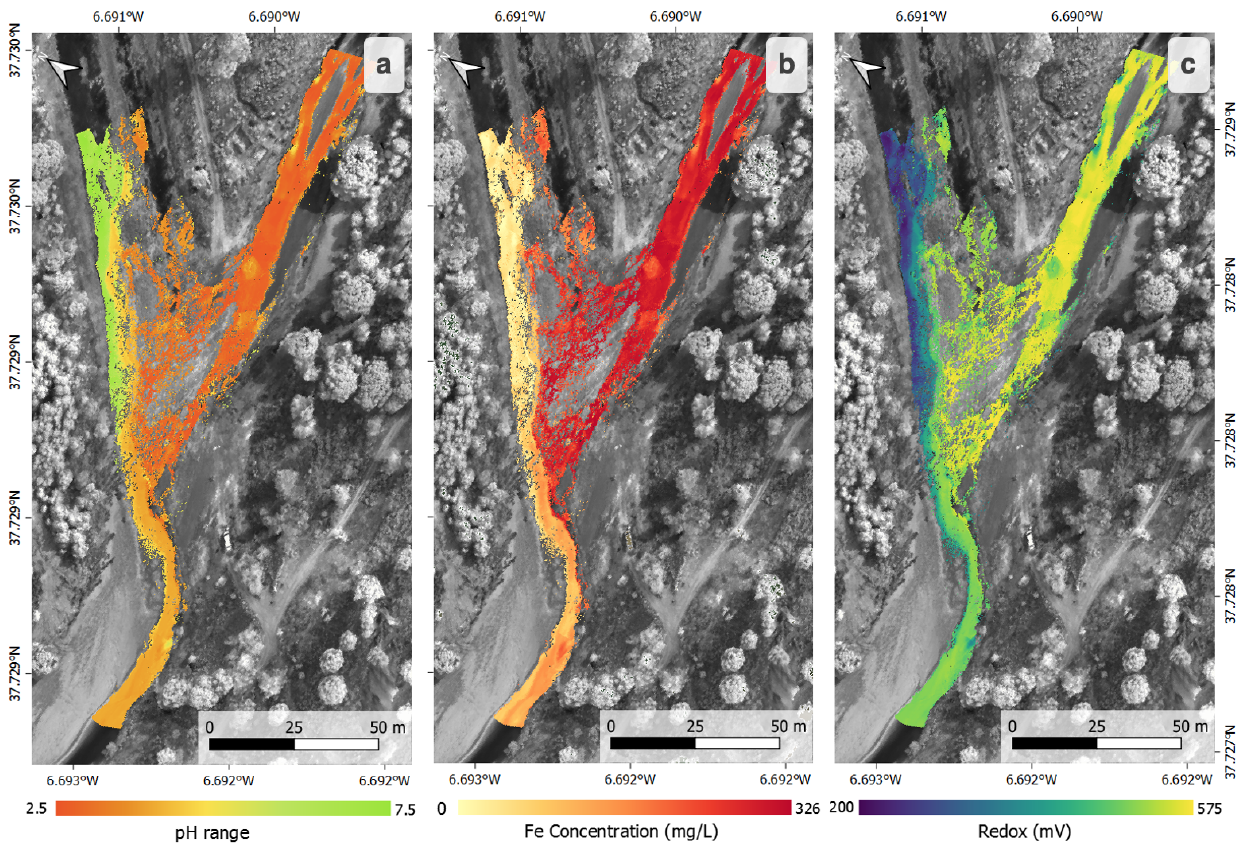
Figure 10. Multivariate RF regression maps. ( a ) pH conditions, ( b ) Fe concentration in water, and ( c ) redox conditions. Map were rotated 55° for better visualization.